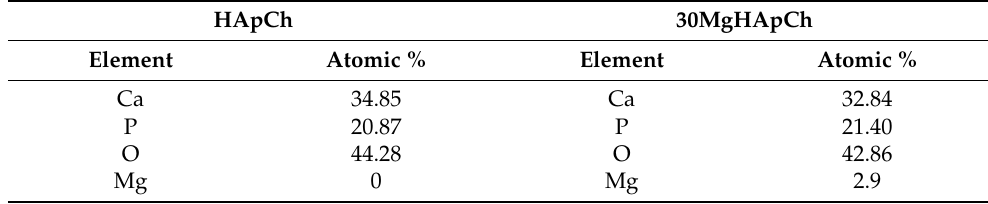
Table 2. Concentration of Ca, P, O and Mg (%).